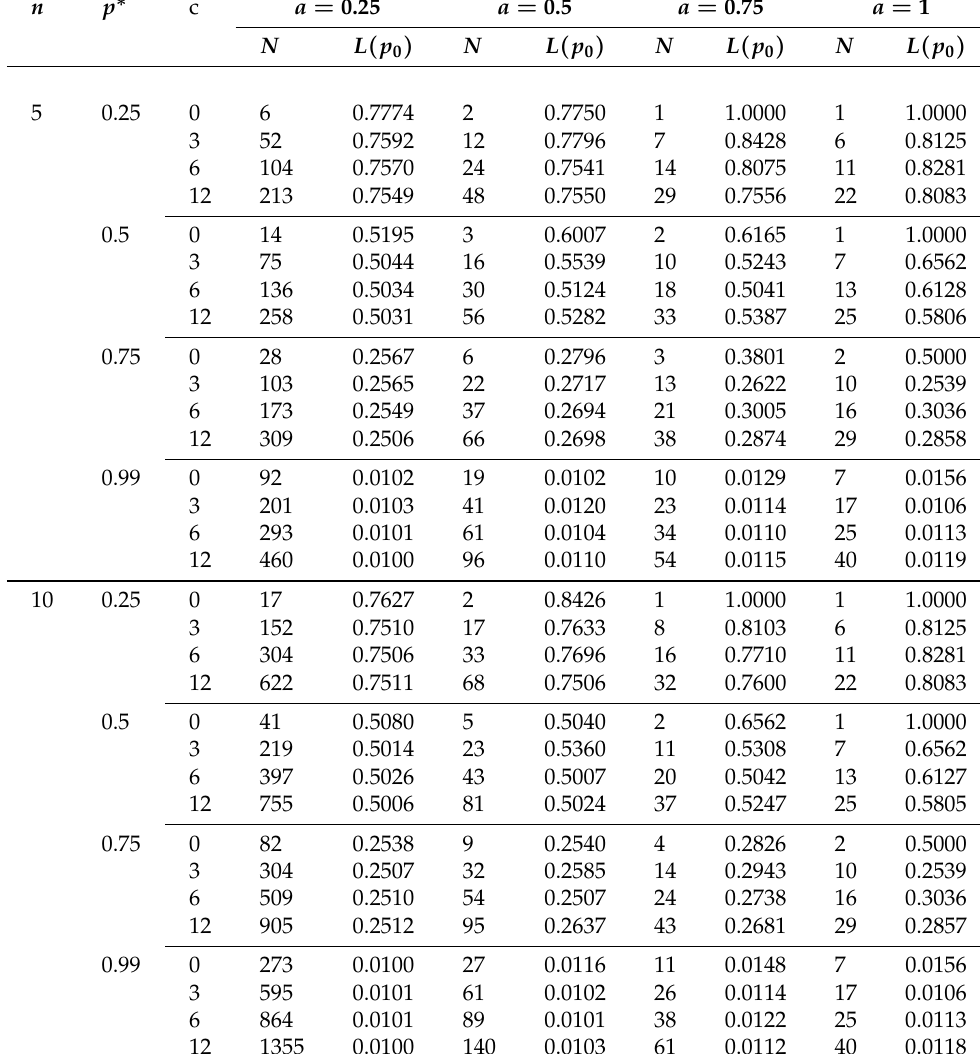
Table 6. Numerical outcomes of a single sampling plan for FB model at combination